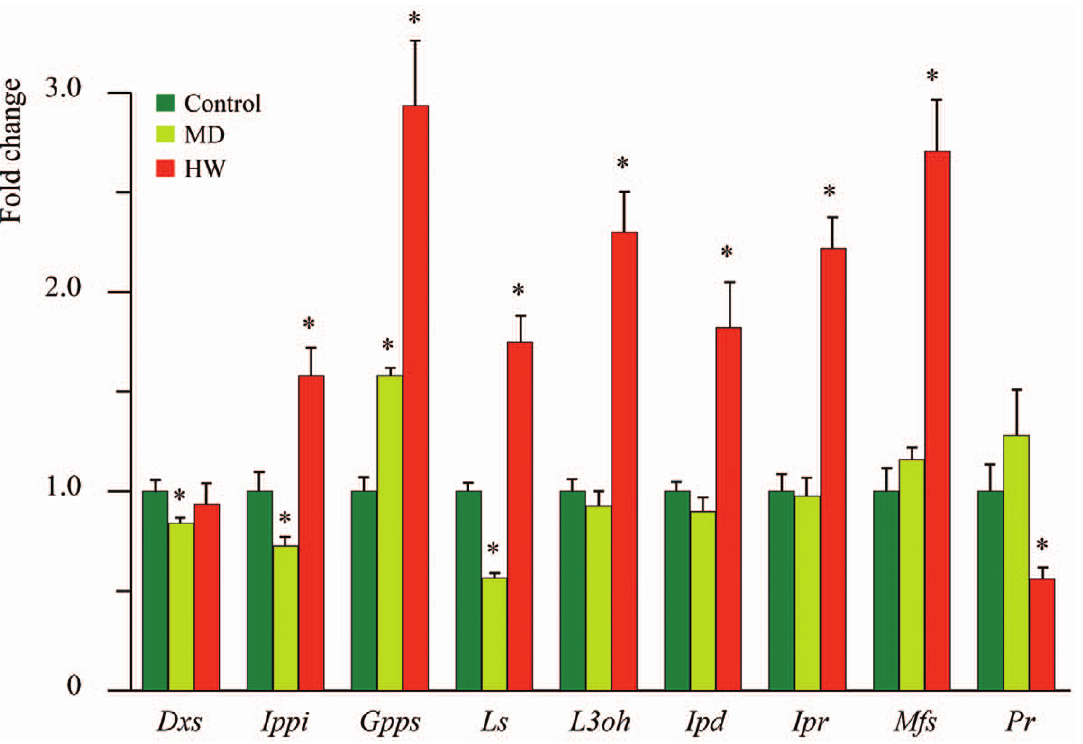
Figure 5. qPCR terpenoid gene expression of M.aquatica in mechanically damaged (MD) and herbivore damaged (HW) leaves, with respect to control leaves. Bars indicate the standard error over the mean of at least three biological replicates. Asterisks indicate significant differences with respect to controls (P , 0.05).